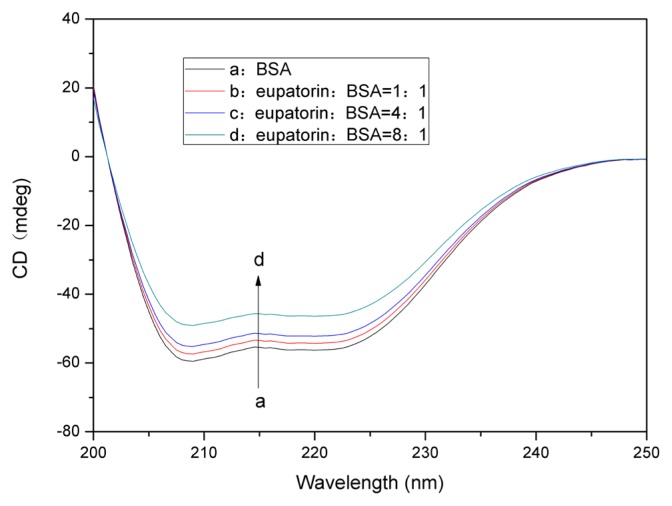
CD spectra of the eupatorin–BSA system (pH 7.4, T = 310 K). CBSA = 5.0 × 10−7 M; eupatorin to BSA ratios: (a) 0:1; (b) 1:1; (c) 4:1; and (d) 8:1.